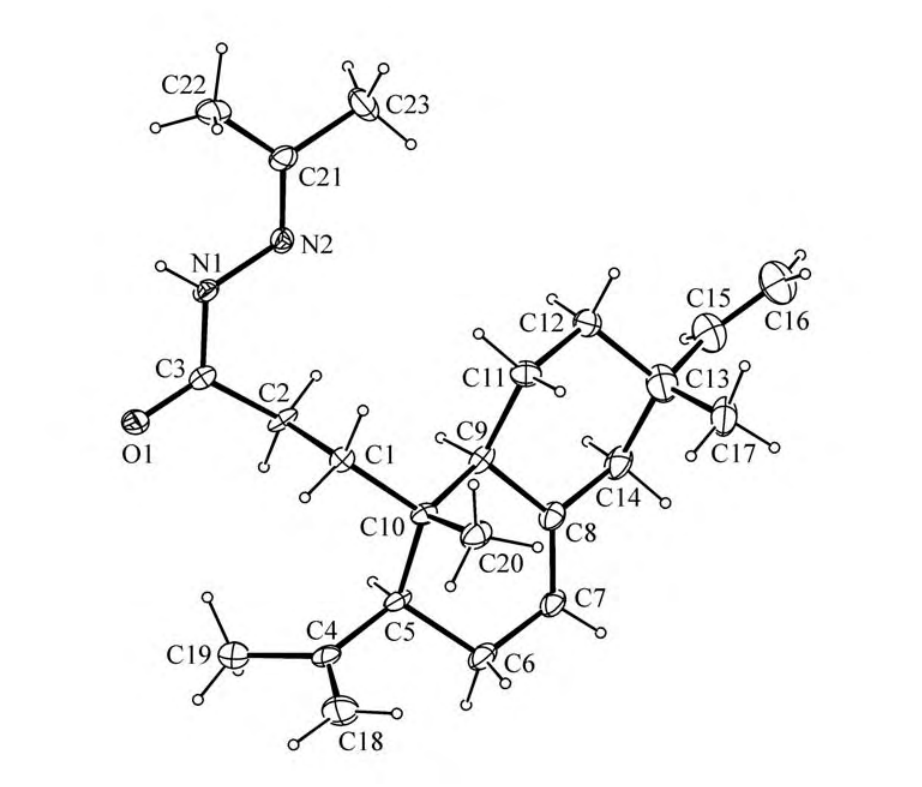
Figure 1. The molecular structure of 4 , with the atomic labelling for non-H